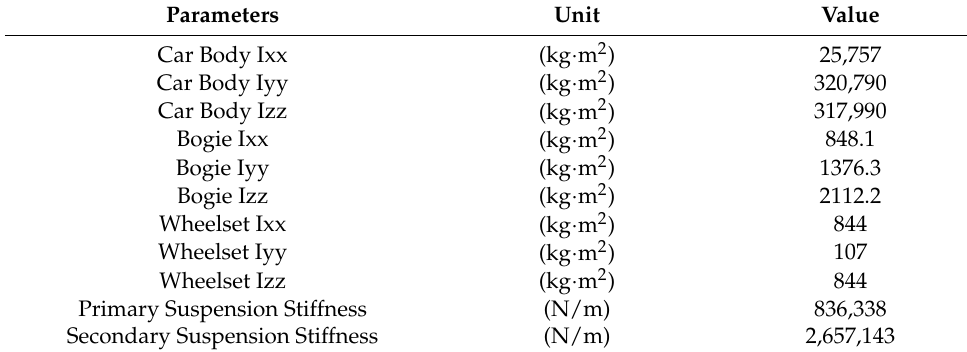
Table 3. Modeling values of inertia and stiffness.